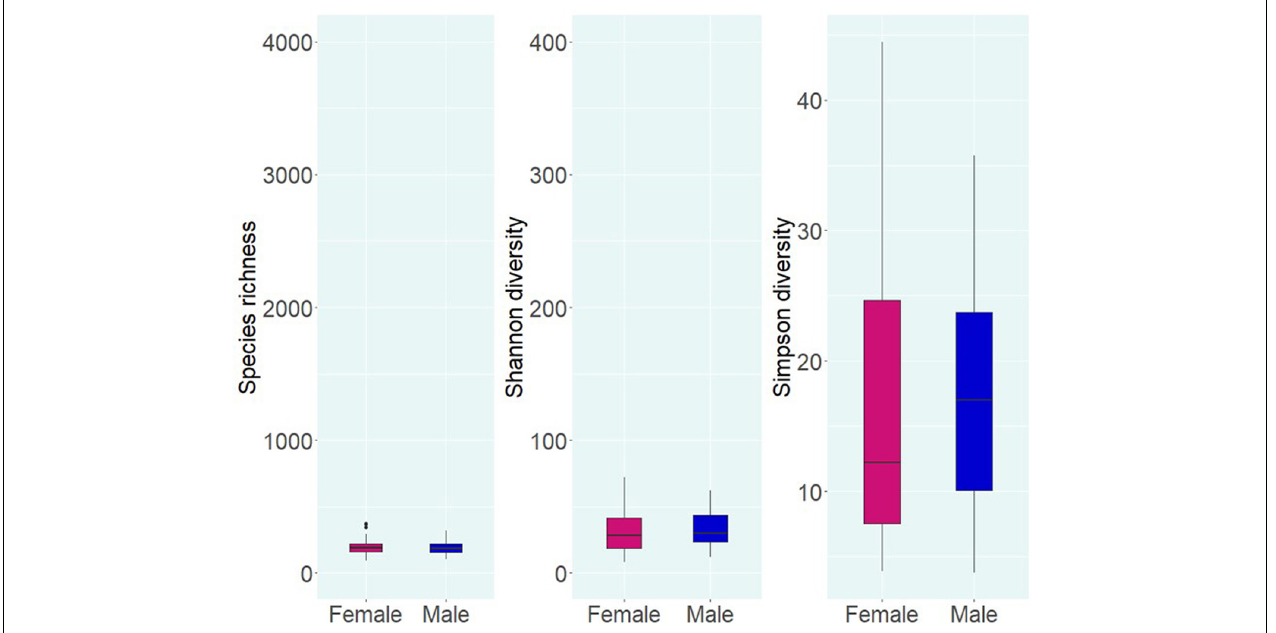
FIGURE 2 | Alpha diversity of the bacteria in the buccal cavity of female and male Nile tilapia. Species richness, Shannon diversity, and Simpson diversity of the groups are not significantly different. The boxplots show minimum, lower quartile, median, upper quartile, and maximum values.